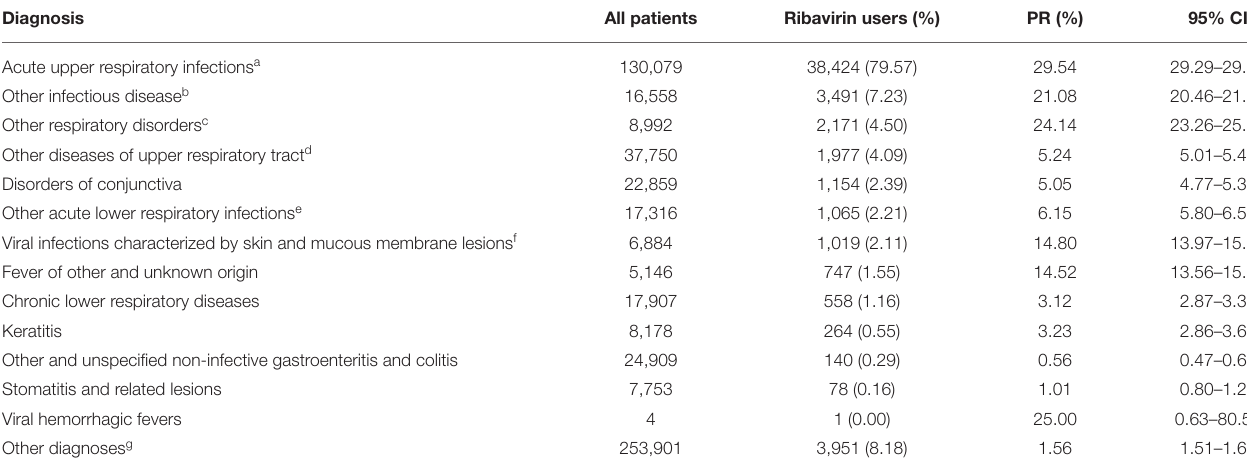
TABLE 3 | Prevalence of IV ribavirin users among patients with different diagnoses. Diagnosis All patients